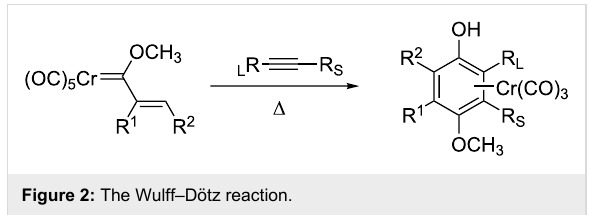
Figure 2: The Wulff–Dötz